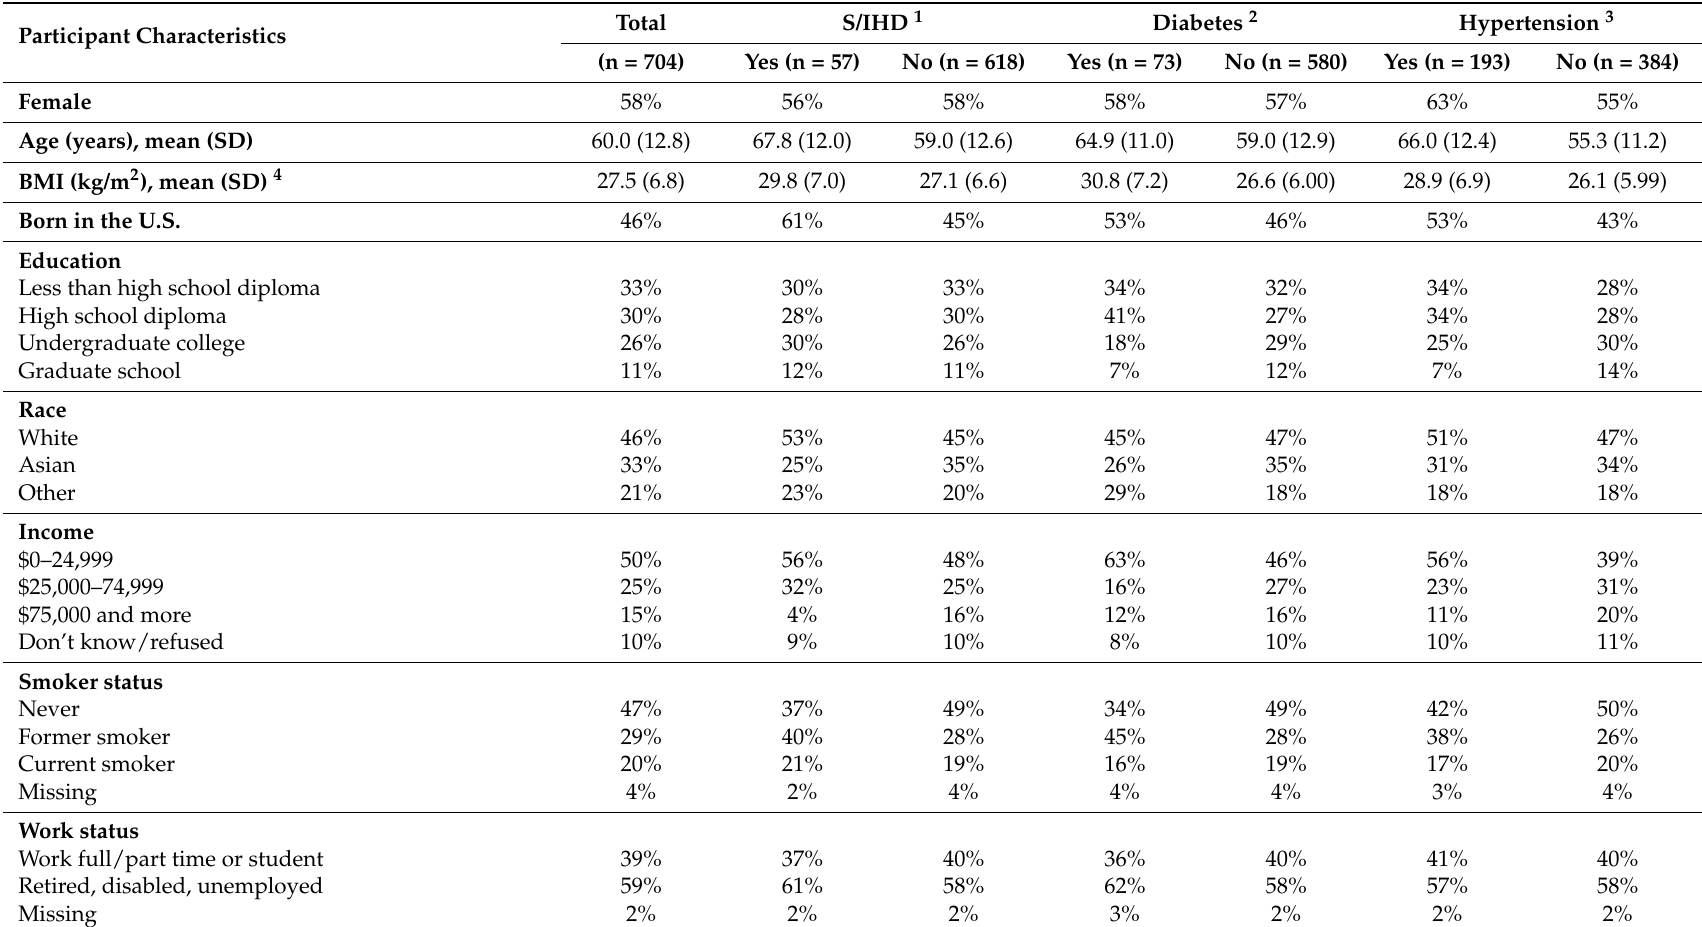
Table 1. Demographic characteristics of total study population by health